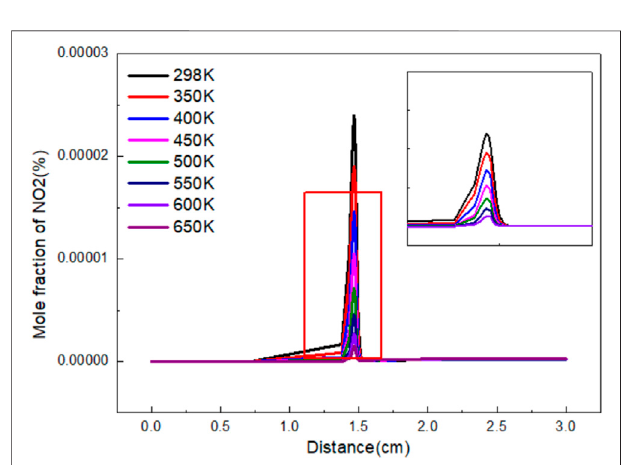
FIGURE 2 | Curve of fl ame velocity with preheating